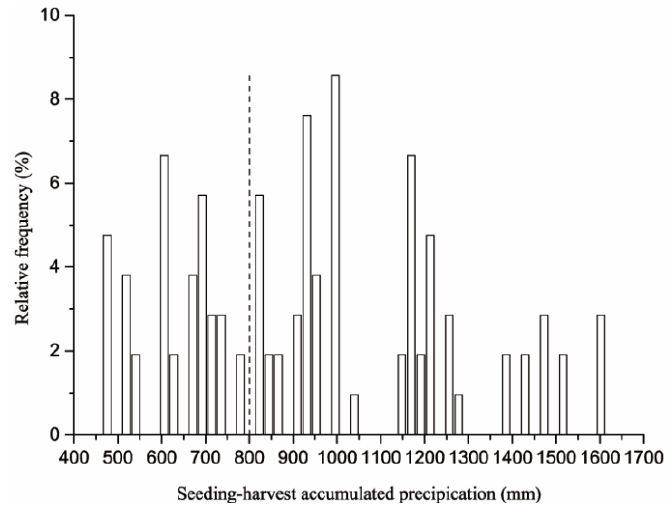
Figure 1. Seeding–harvest accumulated precipitation frequency in the sorghum–sudangrass hybrid dataset (the vertical lines illustrate 800 mm, which is the threshold value of the suitable accumulated precipitation).